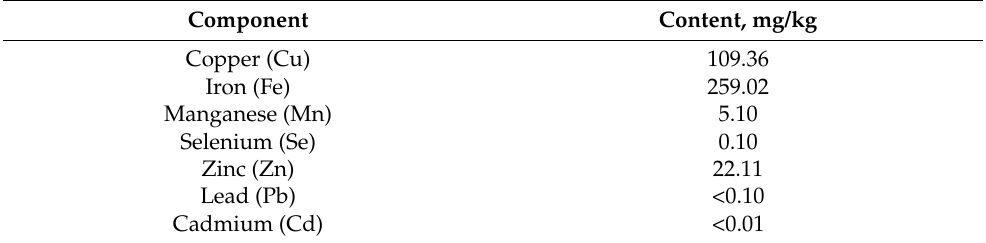
Table 3. Selected microelements and heavy metal contents of sunflower meal ethanol-wash